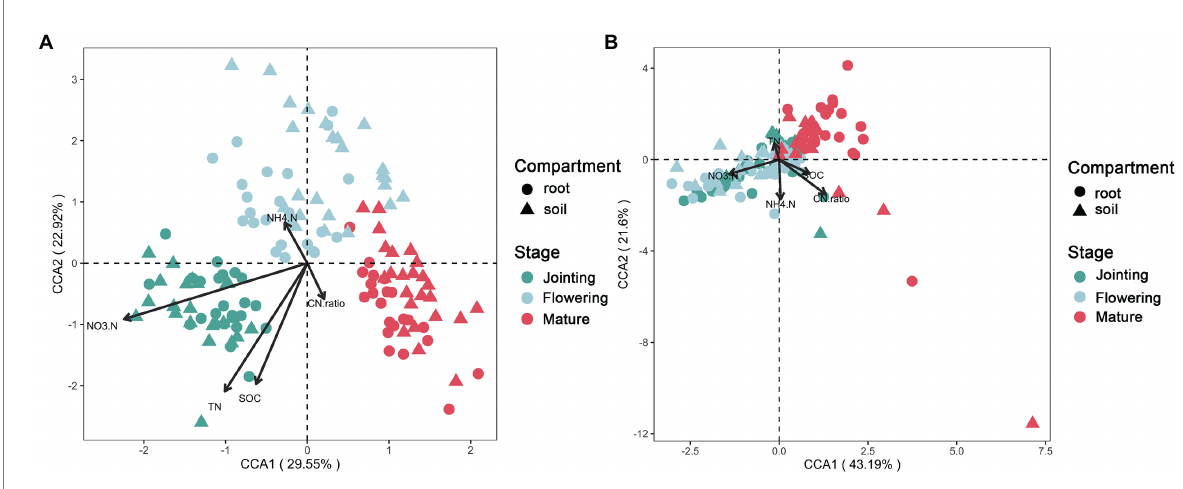
FIGURE 1 Canonical correspondence analysis of the (A) bacterial and (B) fungal beta-diversity and soil properties at three growth stages of